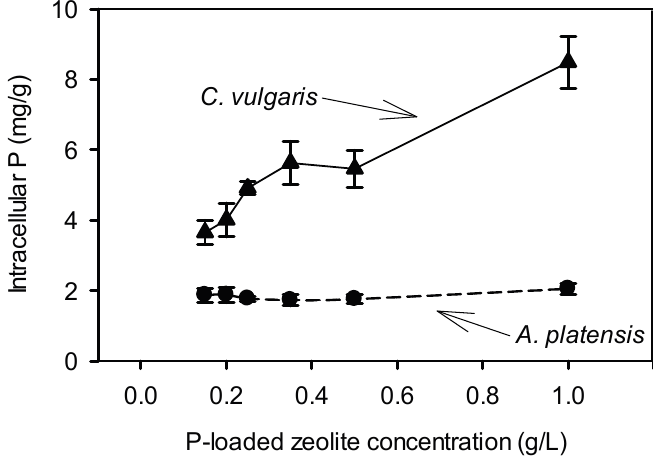
Figure 5. P-recovery of bounded P onto zeolite. Physical/chemical desorption zone refers to the mass of P desorbed from zeolite into control medium without microalgae.